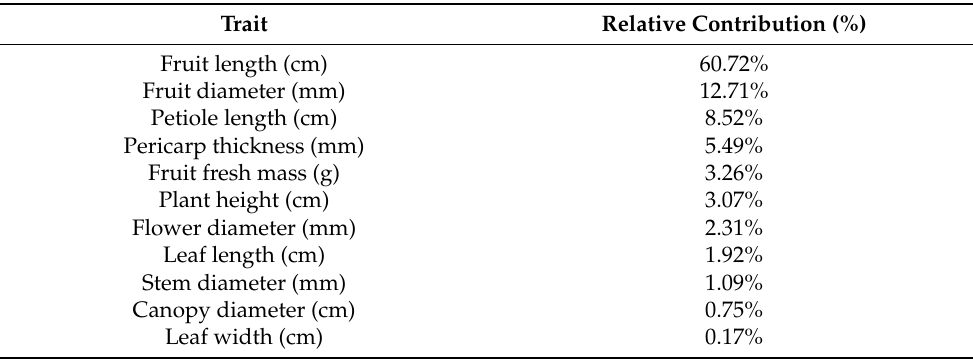
Table 2. Relative contribution of 11 quantitative traits to genetic divergence among 69 Capsicum accessions by the Singh